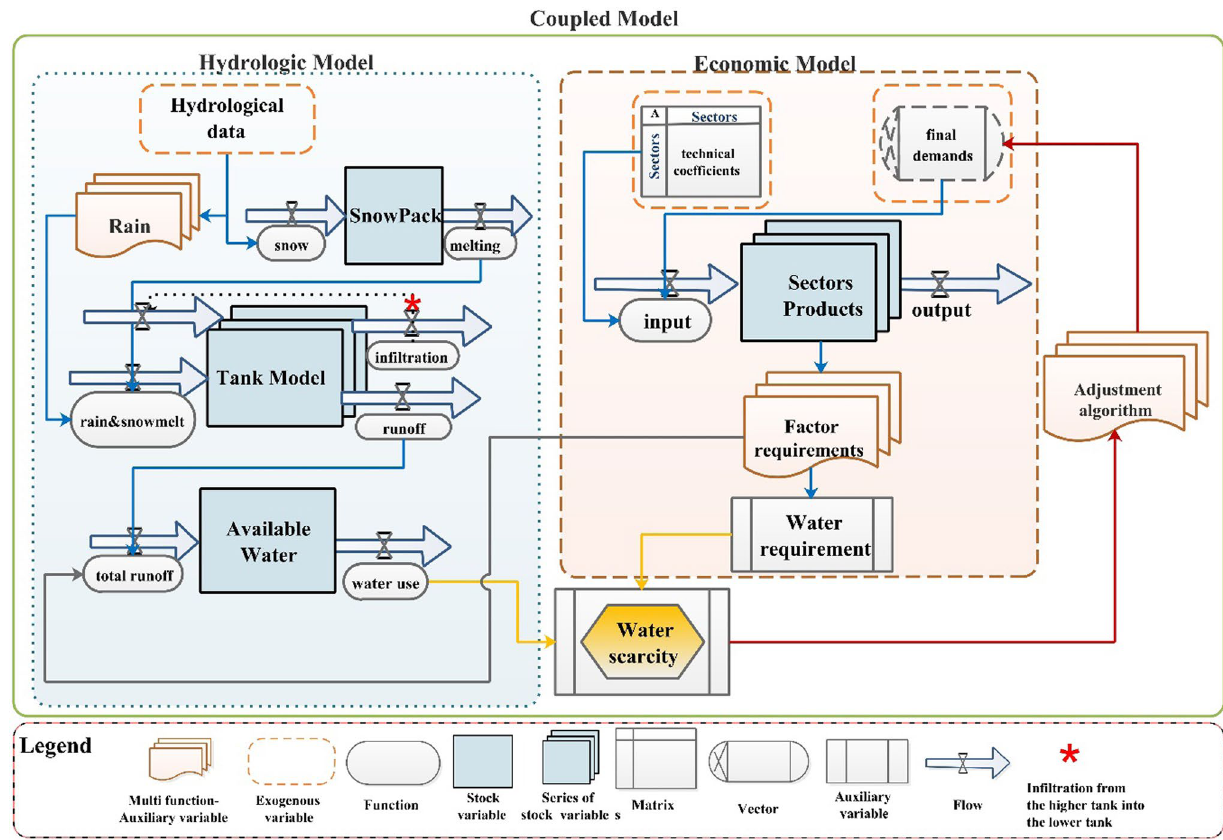
Fig. 1 Schematic of the system dynamic